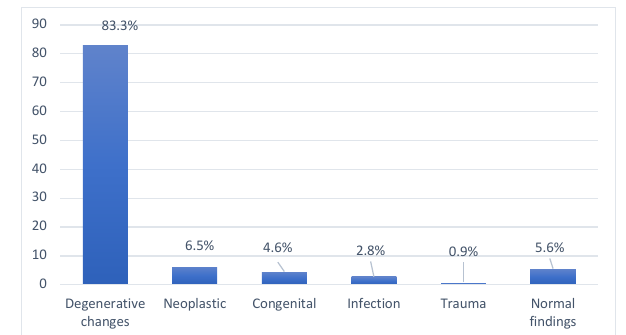
Fig. 1. Spectrum of spinal pathologies in MRI findings of patients with chronic